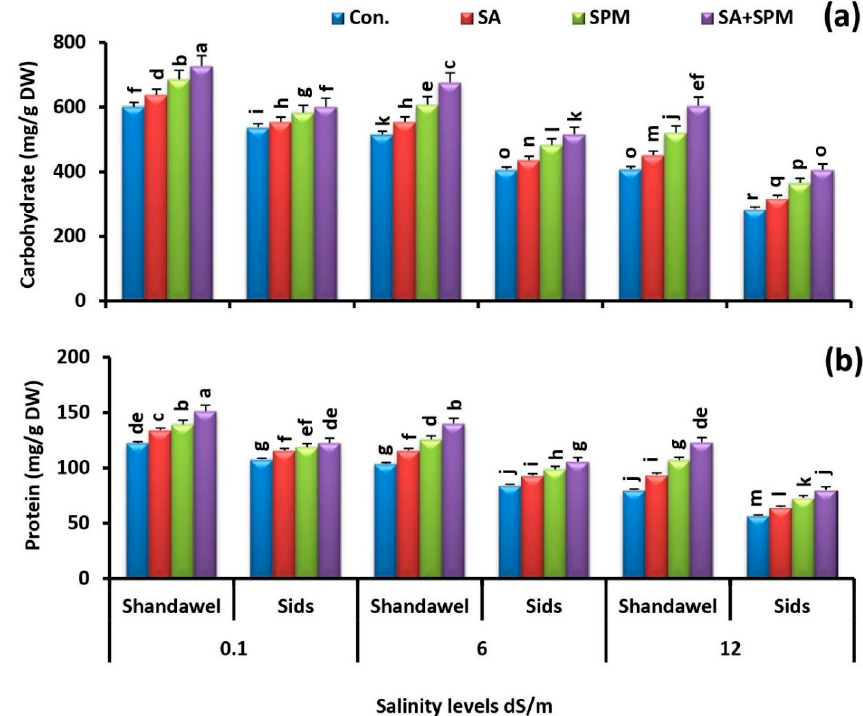
Figure 10. Influence of salicylic acid (SA; 100 mgL − 1 ) and/or spermine (SPM; 30 mgL − 1 ) on the content of ( a ) carbohydrate and ( b ) protein in grains of two wheat cultivars (Shandawel 1 and Sids 14) grown under 0.1, 6, and 12 dS m − 1 salinity levels. Data are mean of four replicates (n = 4). Different letters indicate significant differences at ( p < 0.05) level, according to Duncan’s